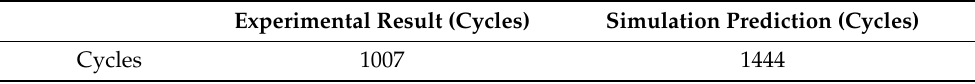
Table 2. Finite element model validation.